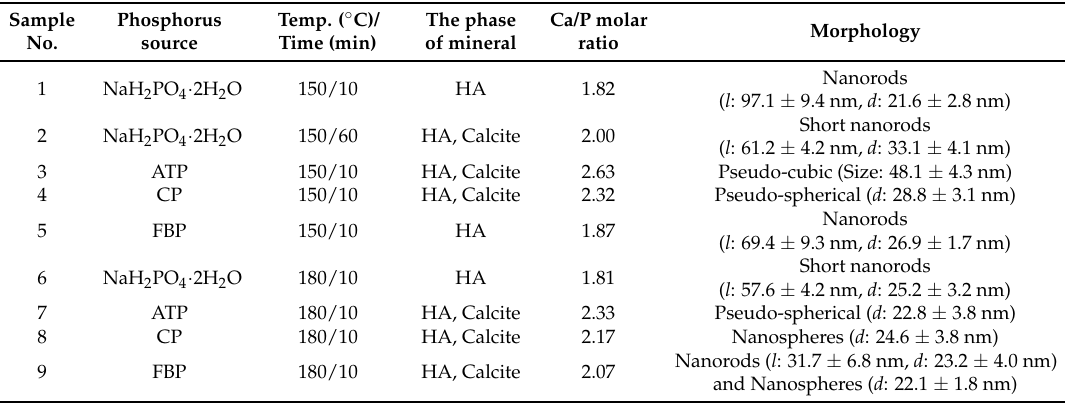
Table 1. The experimental parameters for the preparation of typical cellulose/HA nanocomposites, and their morphologies, Ca/P molar ratios, and the components of the mineral in the nanocomposites. Sample